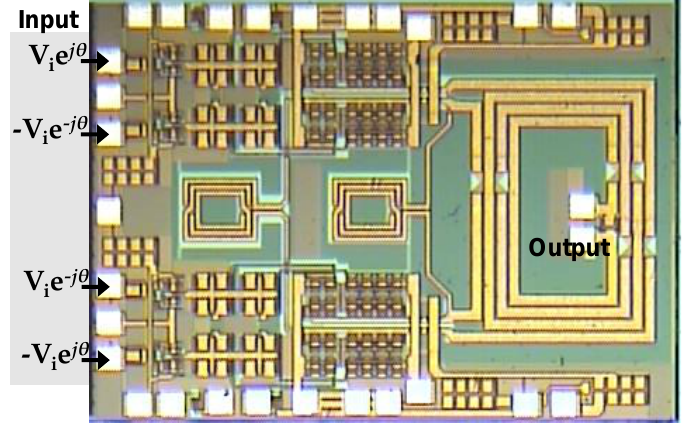
Figure 12. Die photograph of on-chip outphasing CMOS PA.